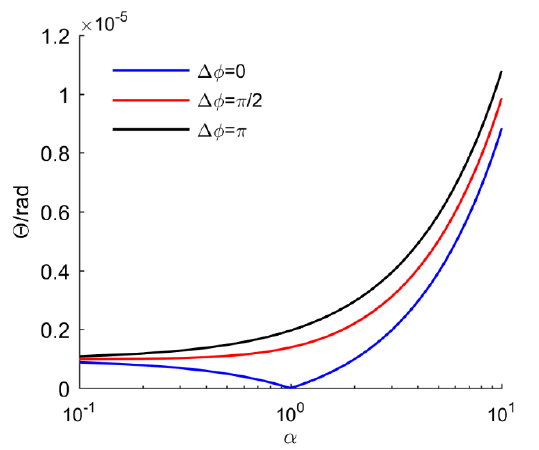
Figure 8. The influence of amplitude ratio and phase difference on the peak value of output light angle response.